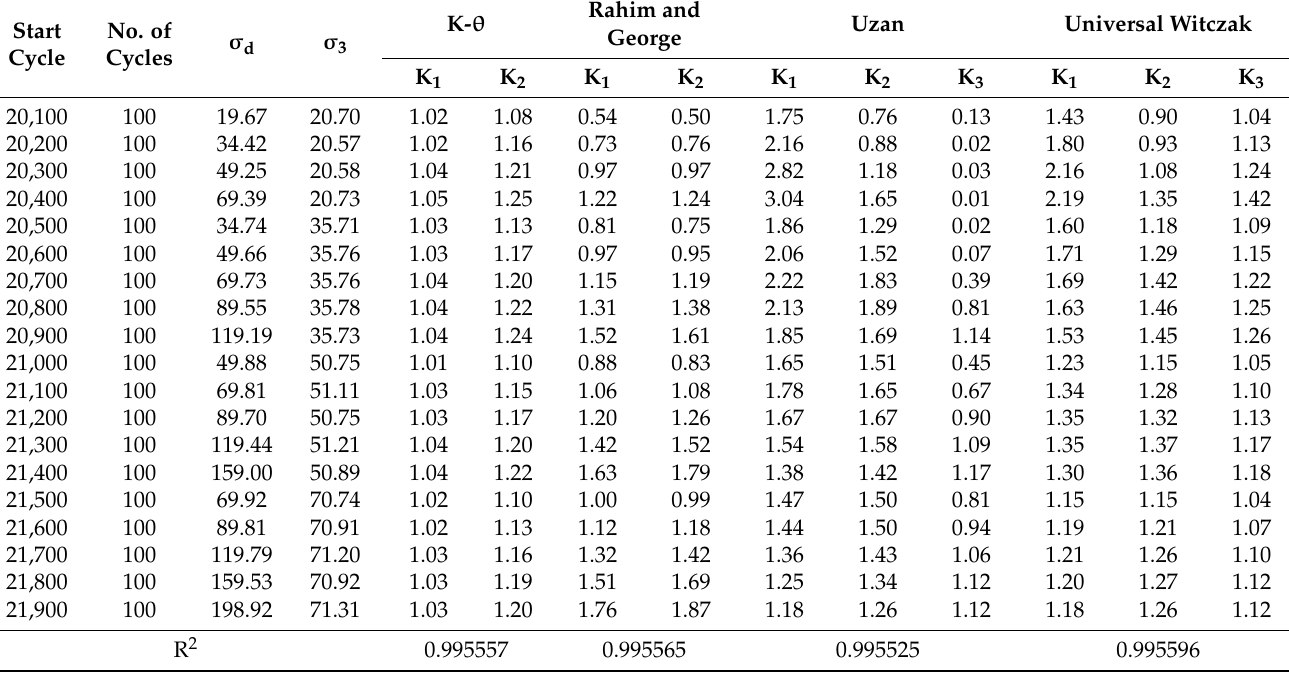
Table 3. Determination of models’ average regression coefficients for specimen